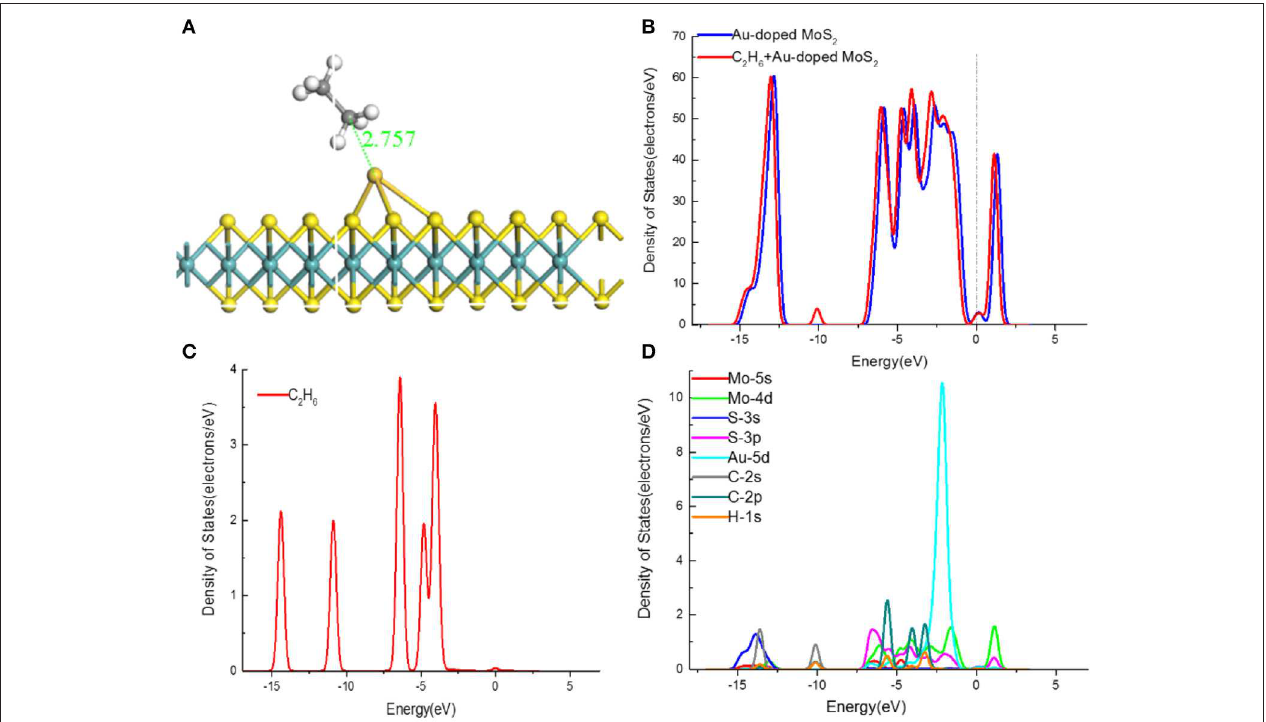
FIGURE 5 | (A) The structures, (B) TDOS, (D) PDOS of C 2 H 6 -adsorbed MoS 2 monolayer, and (C) the TDOS of C 2 H 6 molecular.